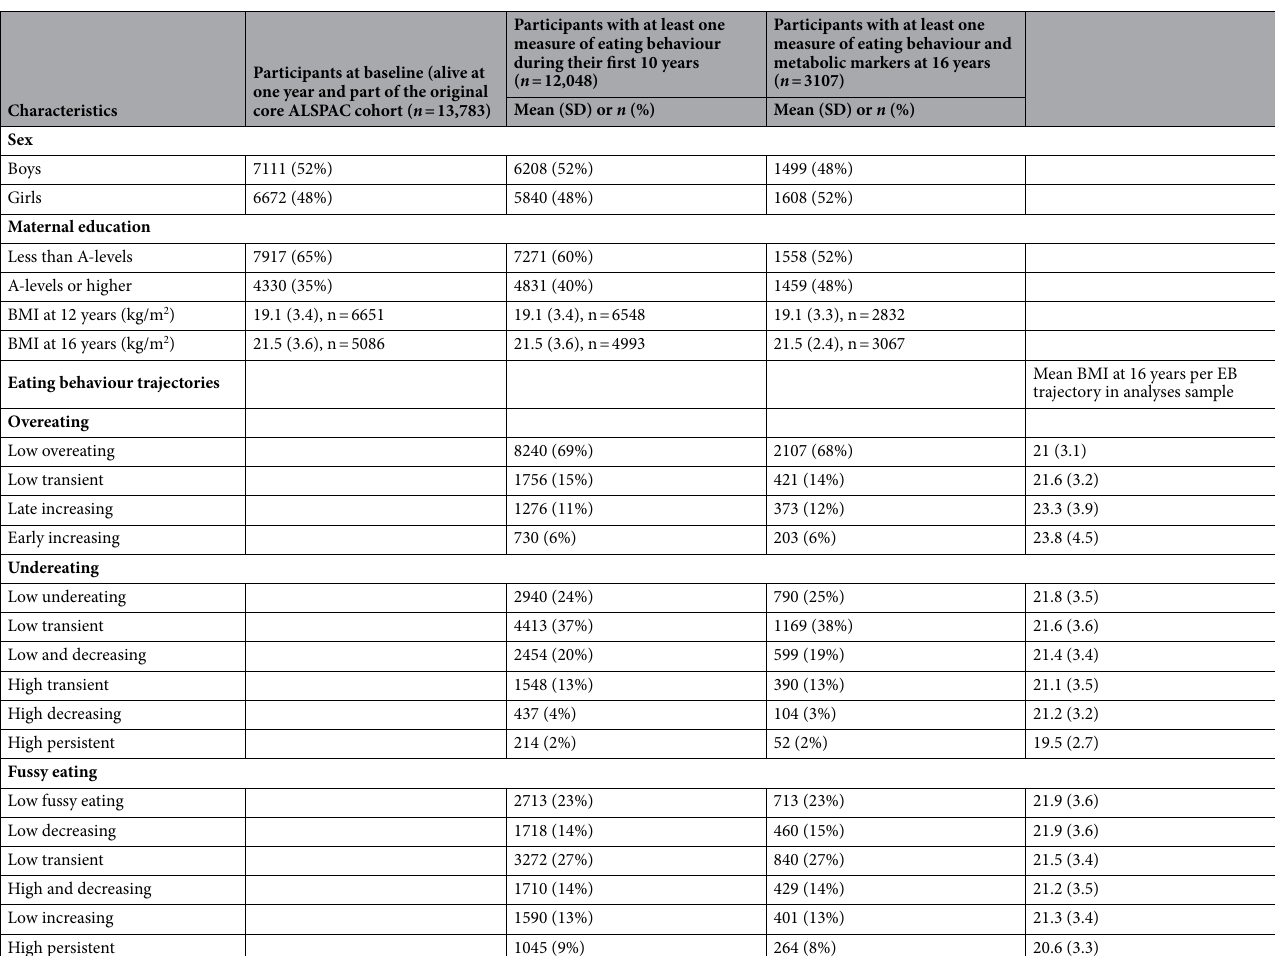
Table 1. Eating behaviours and characteristics of the subsamples of the Avon Longitudinal Study of Parents and Children (ALSPAC) that were included in the construction of the eating behaviour trajectories using latent class growth analysis 27 and the subsample that also has an available metabolic profile at age 16 years. BMI body mass index, EB eating behaviour, n number, SD standard